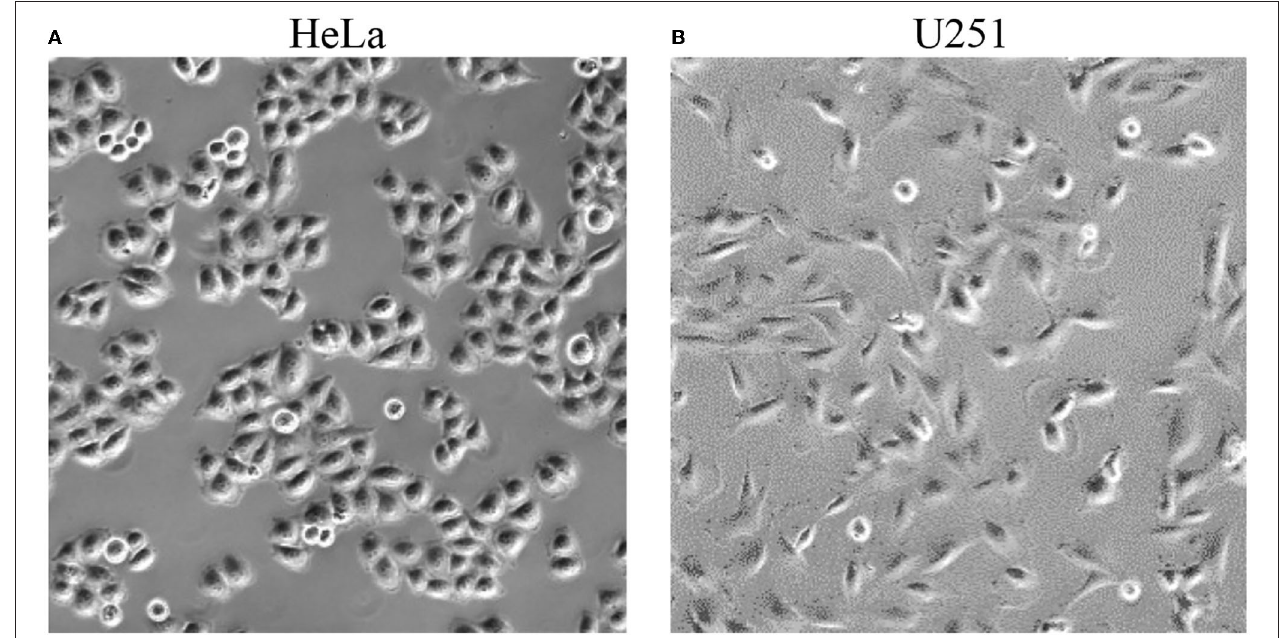
FIGURE 2 | Representative photographs of HeLa (left, A ) and U251 (right, B ) cells taken before exposure to TTFields and the Vielight